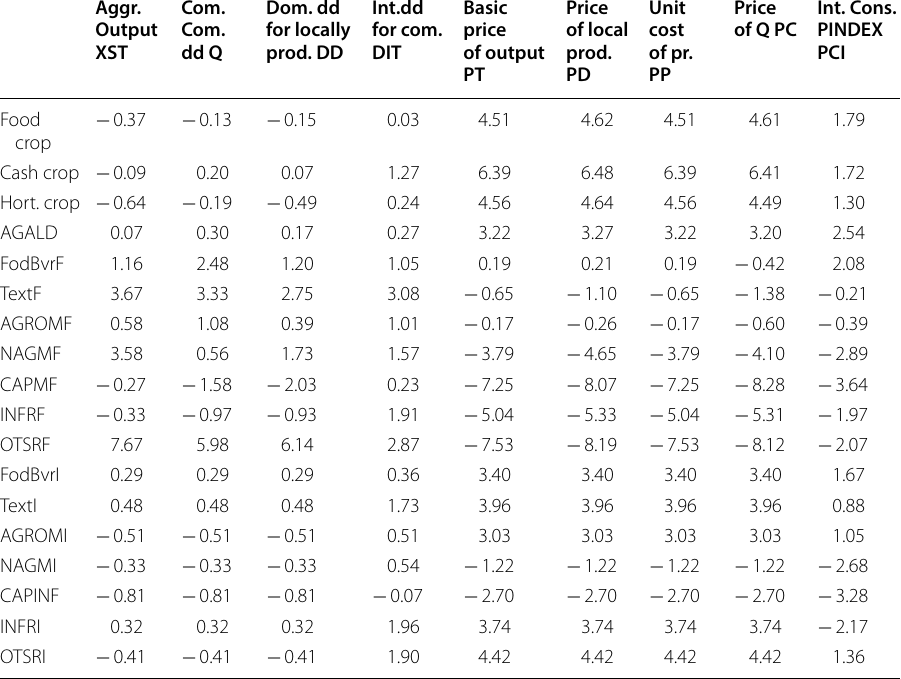
Table 10 (Scenario A3-S1) Change (%) in quantity and price due to 50% tariff reduction (segmented labour market-2, σ = 0.2